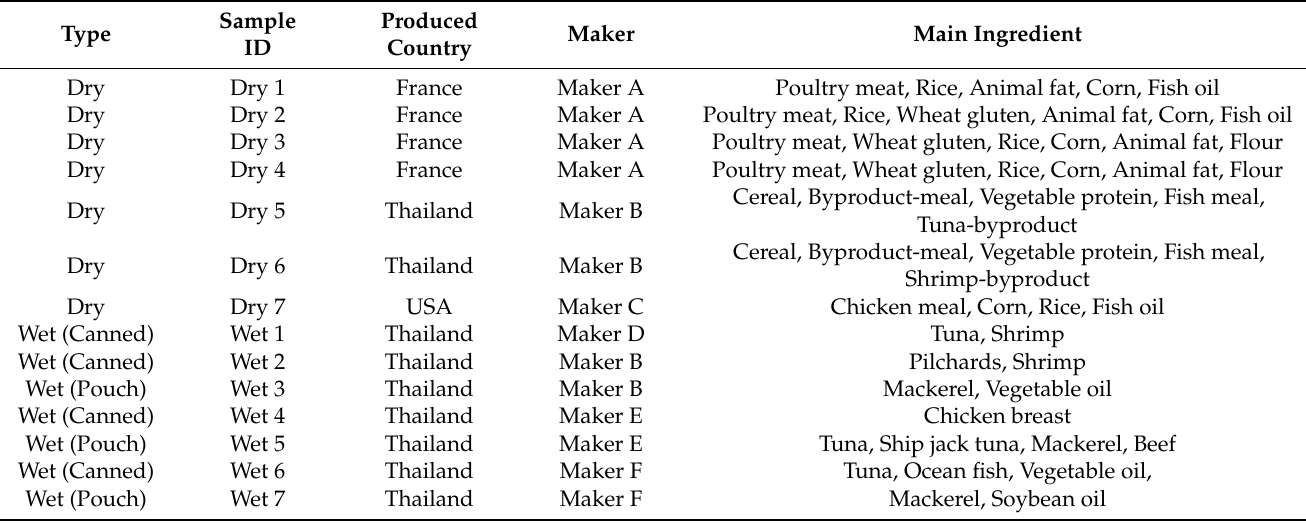
Table 2. Sample information of cat food written on the package labels purchased in